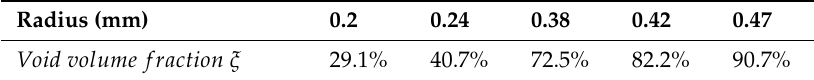
Figure 3. Meshes for architected SMA RVEs with different void volume fractions ξ . Table 3. Geometrical parameters for RVEs.